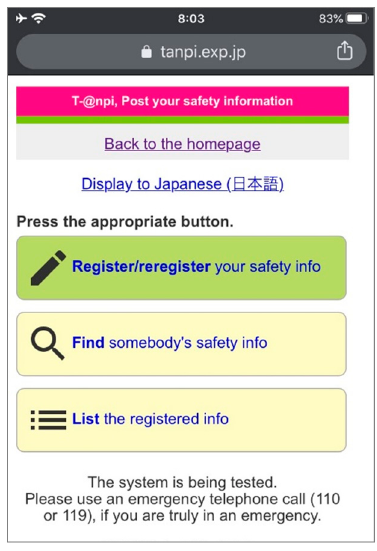
Figure 2. Appearance and operation of the index page.